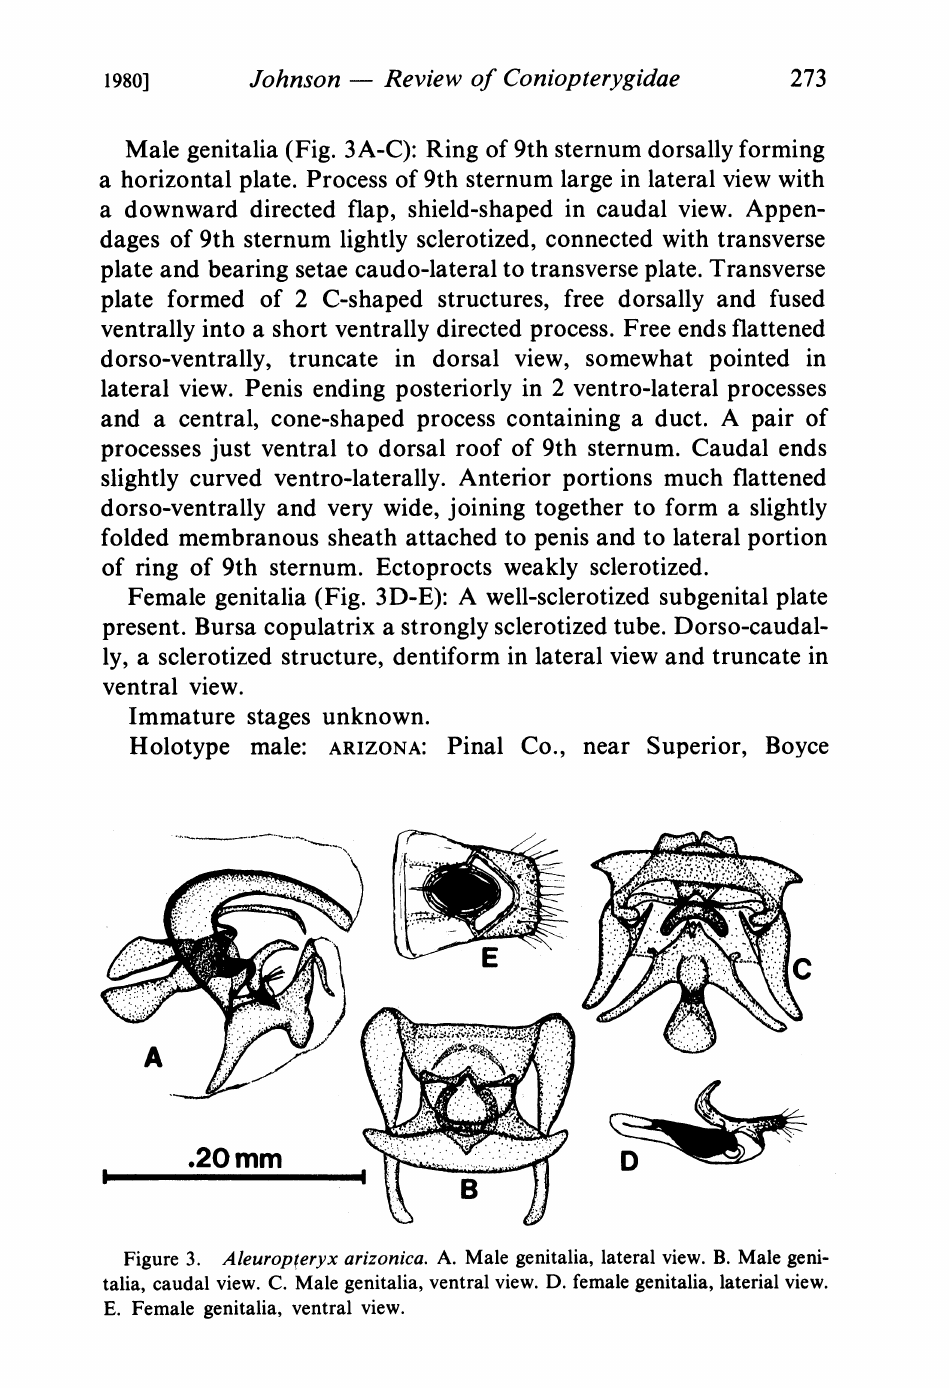
E. Female genitalia, ventral